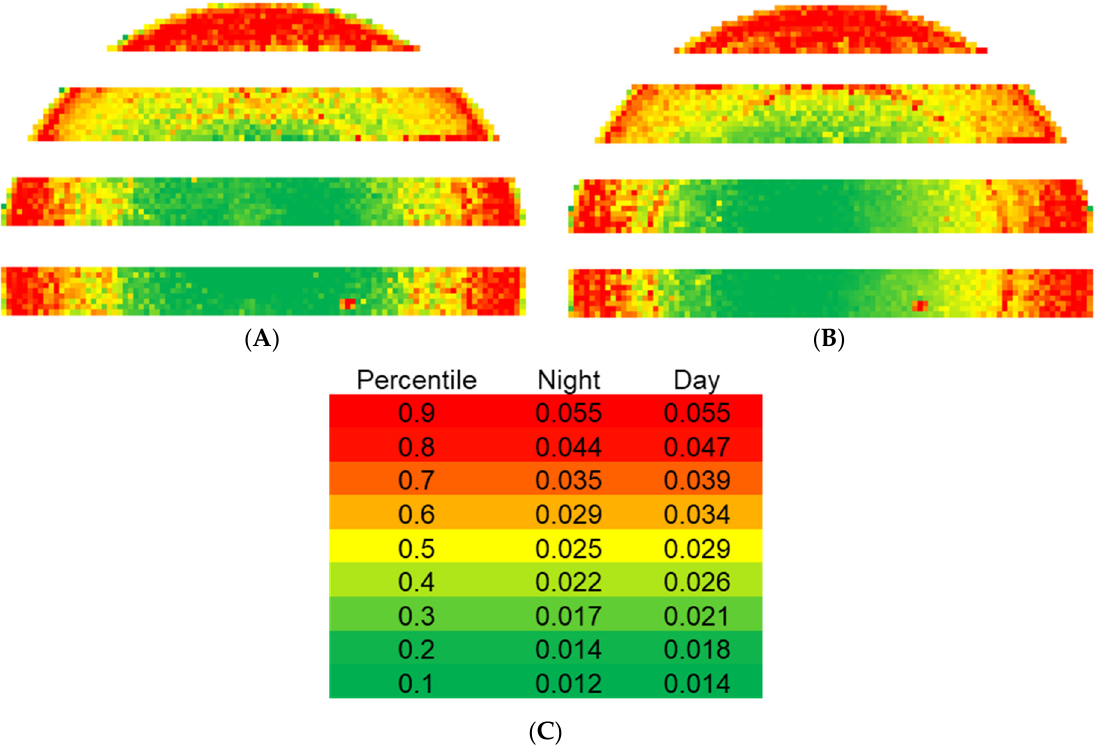
Figure 30. Range of measurements for the Livox ® Mid – 40 during ( A ) night and ( B ) day experiments, ( C ) colored by percentile.